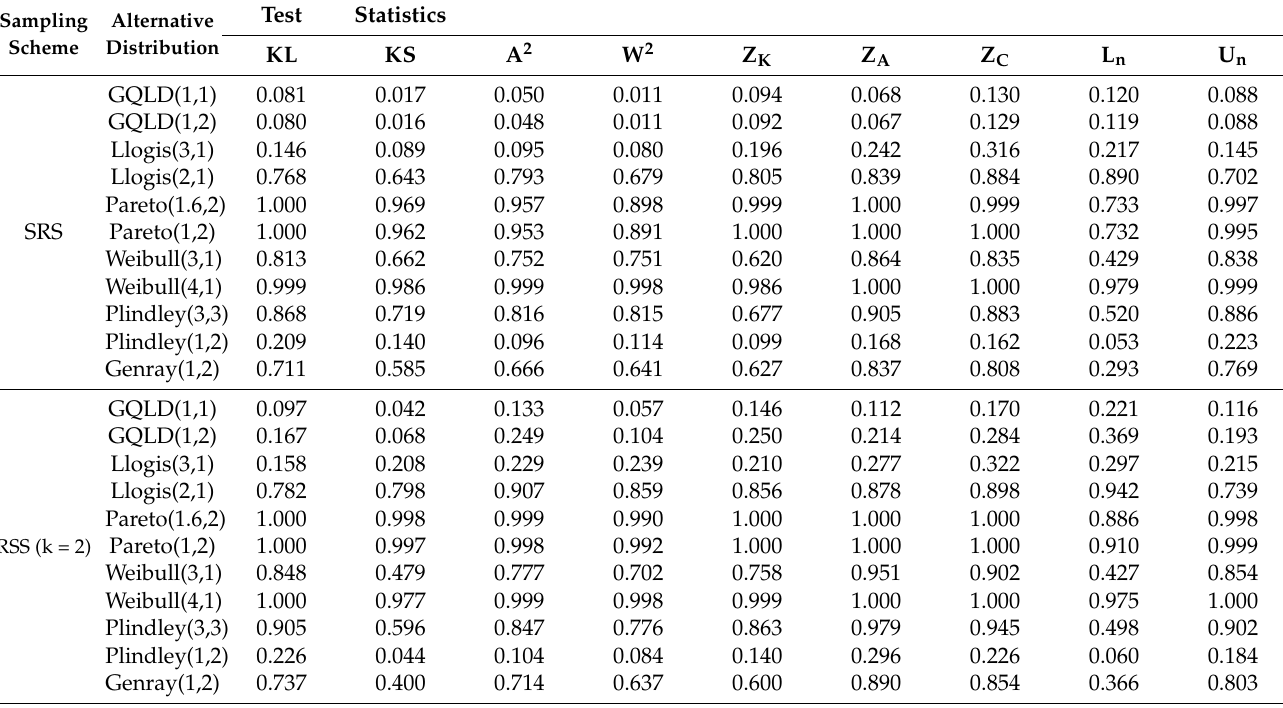
Table 6. Power estimates of different GFT in RSS and SRS for N = 40 and γ =